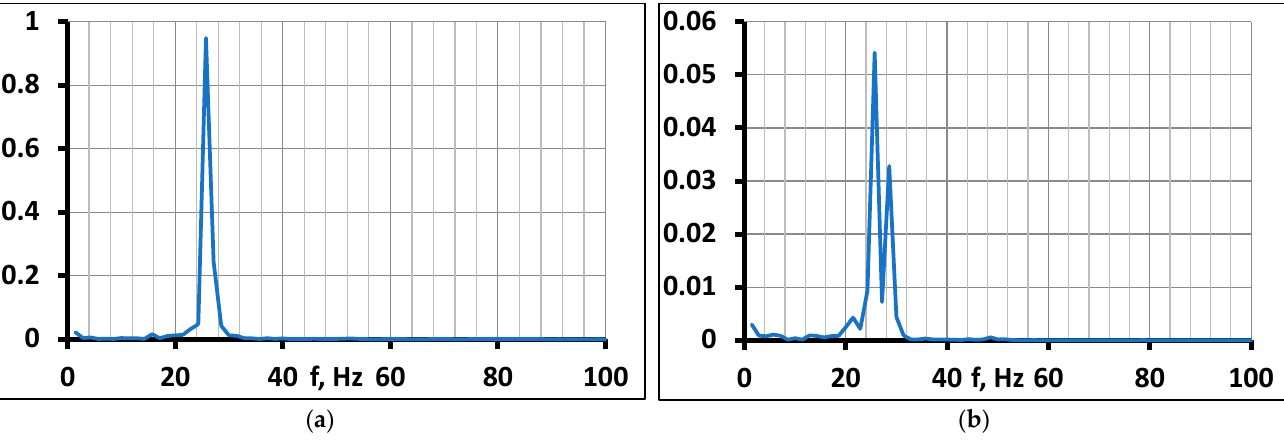
Figure 9. ( a ) The spectrum of the pulsation component of the lifting force (model No. 1); ( b ) The spectrum of the pulsation component of the lifting force (model No. 2).